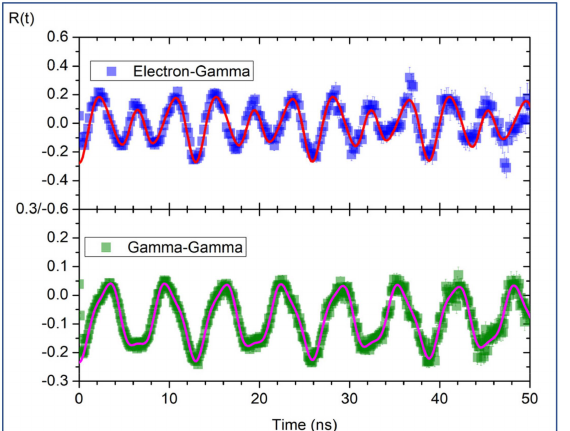
Figure 9. R(t) (with the same scale) between the x-y plane of γ − γ TDPAC spectroscopy setup (lower panel, data points are green dots, and fit is the magenta line) compared with R(t) from sample 8 of e − γ TDPAC spectroscopy setup (upper panel, data points are blue dots and fit is red line). Due to the difference in time calibration (0.101 ns/channel for γ − γ TDPAC spectroscopy and 0.195 ns/channel for e − γ TDPAC spectroscopy), the periodicity of the γ − γ R(t) is roughly twice